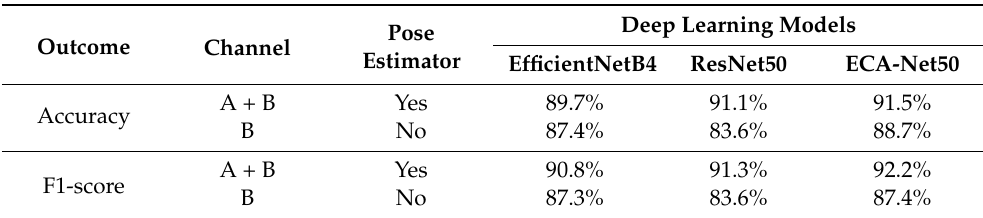
Table 2. Performance of deep learning models (EfficientNetB4, ResNet50, and ECA-Net50) trained using augmented dataset with and without pose estimator.